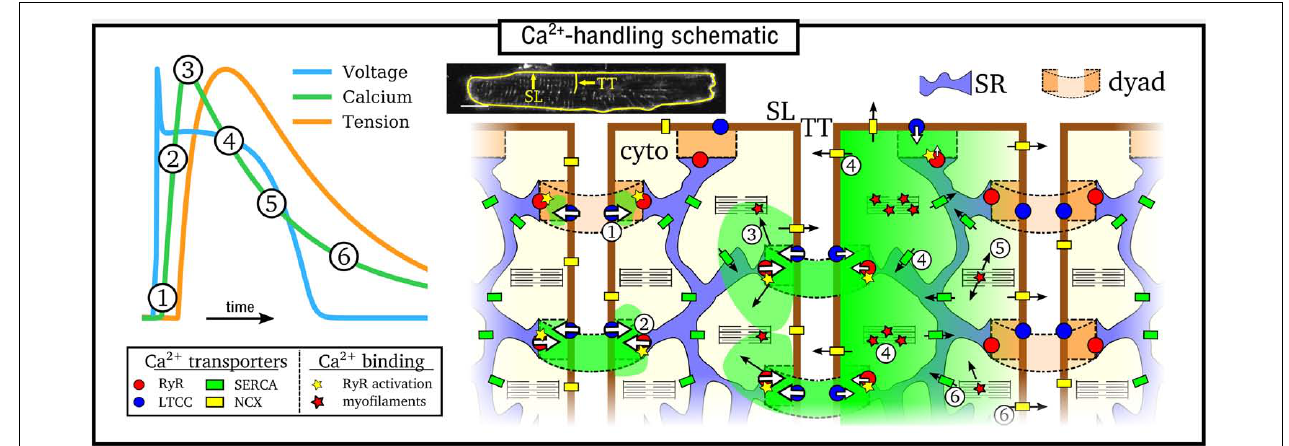
FIGURE 1 | Simplified illustration of the intracellular Ca 2 + -handling cycle in ventricular myocytes. Left: illustration of an action potential (voltage), calcium transient (CaT), and developed tension, with the different stages broadly labeled on the CaT. Right: cartoon schematic of the different stages of Ca 2 + cycling in the intracellular volume. High Ca 2 + concentration is indicated by the green areas; SL refers to the sarcolemmal membrane and TT to a transverse tubule, illustrated on a real cell image (modified from Gadeberg et al., 2016). Numbered stages correspond to those in the main text and are illustrated at different spatial locations of the schematic for brevity – it should be clarified that all stages occur throughout the cell